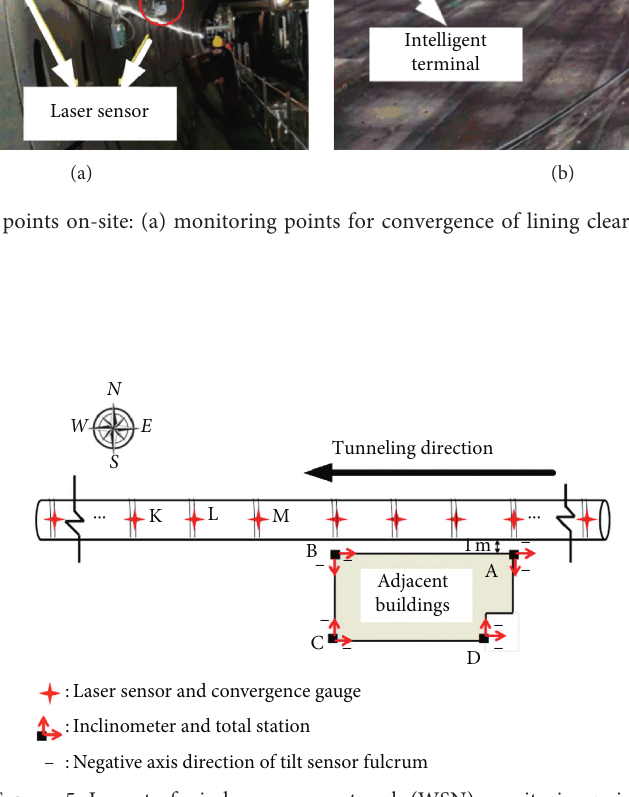
Figure 5: Layout of wireless sensor network (WSN) monitoring points.